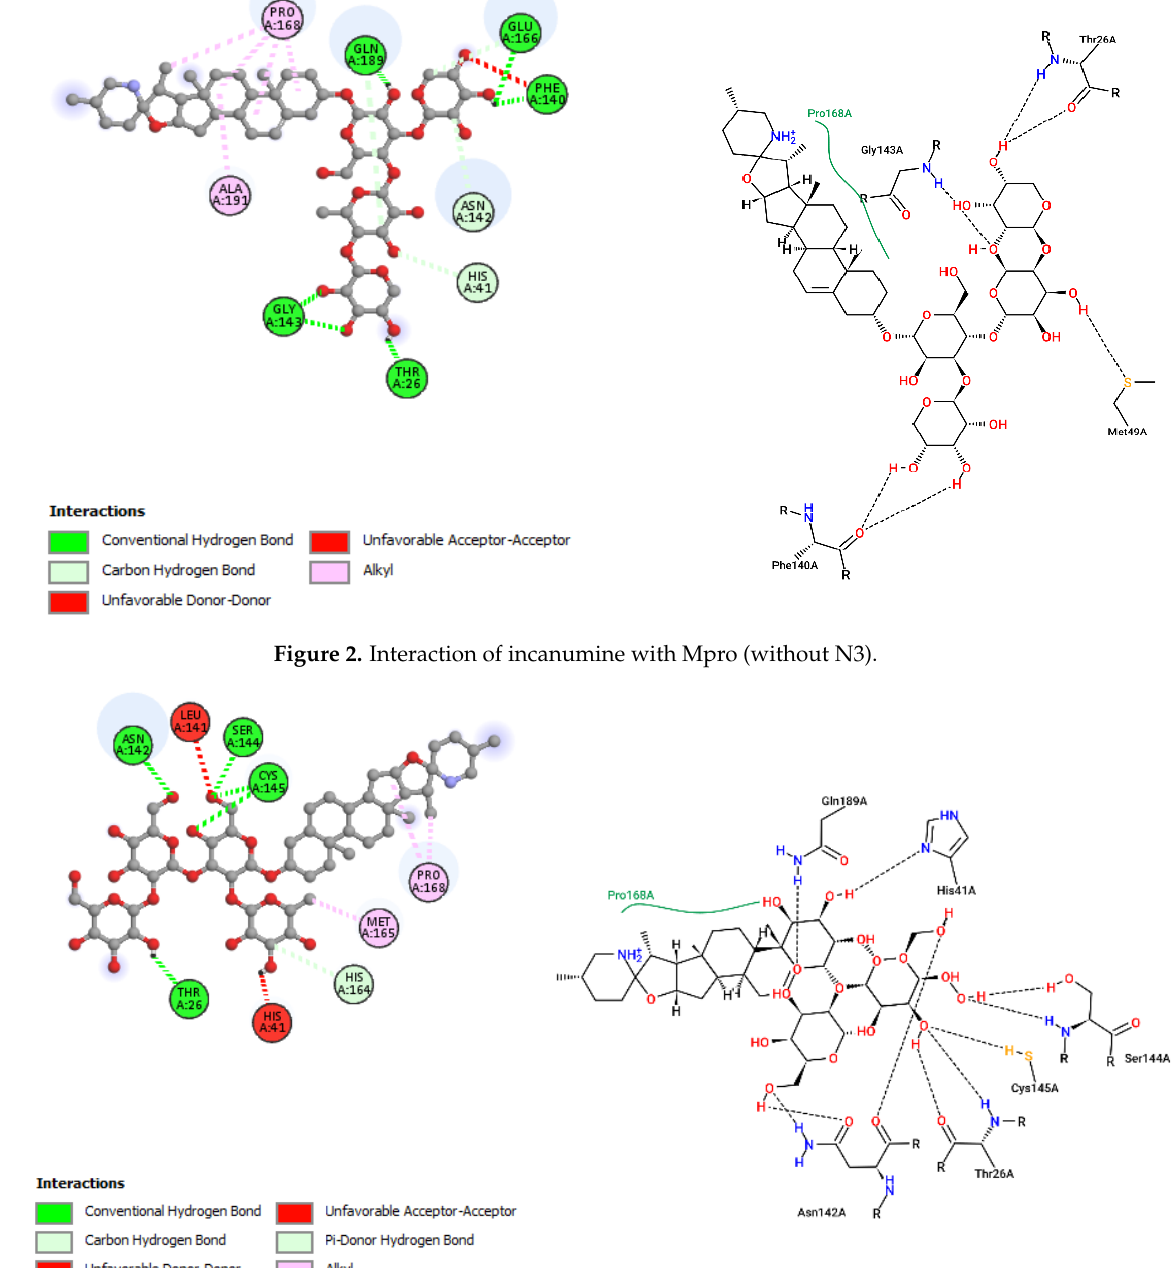
Figure 3 . Interaction of solaradixine with Mpro ( without N3 ). Figure 3. Interaction of solaradixine with Mpro (without